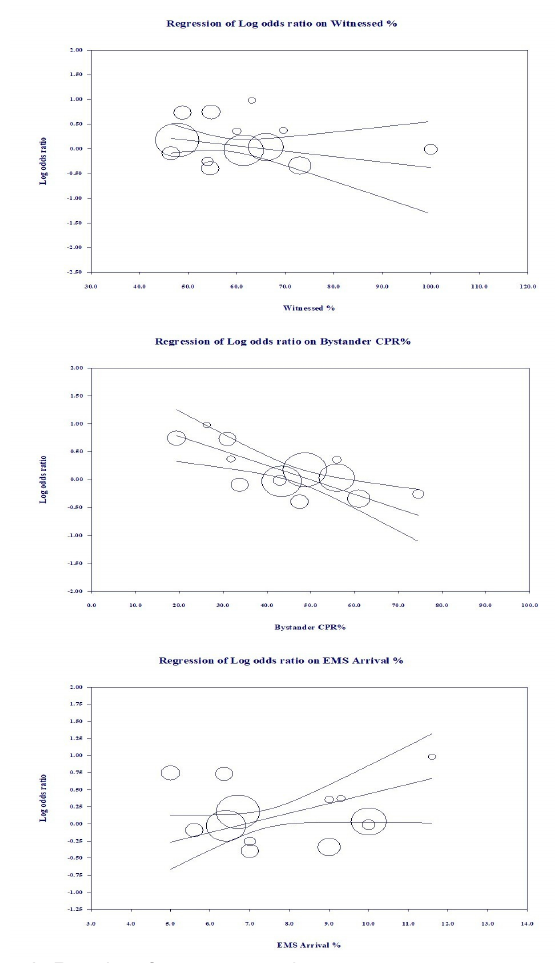
Figure 3. Results of meta-regression. Y = 1.0934 - 0.0121 * Witnessed % - 0.0239 * Bystander CPR% + 0.1079 * EMS Arrival